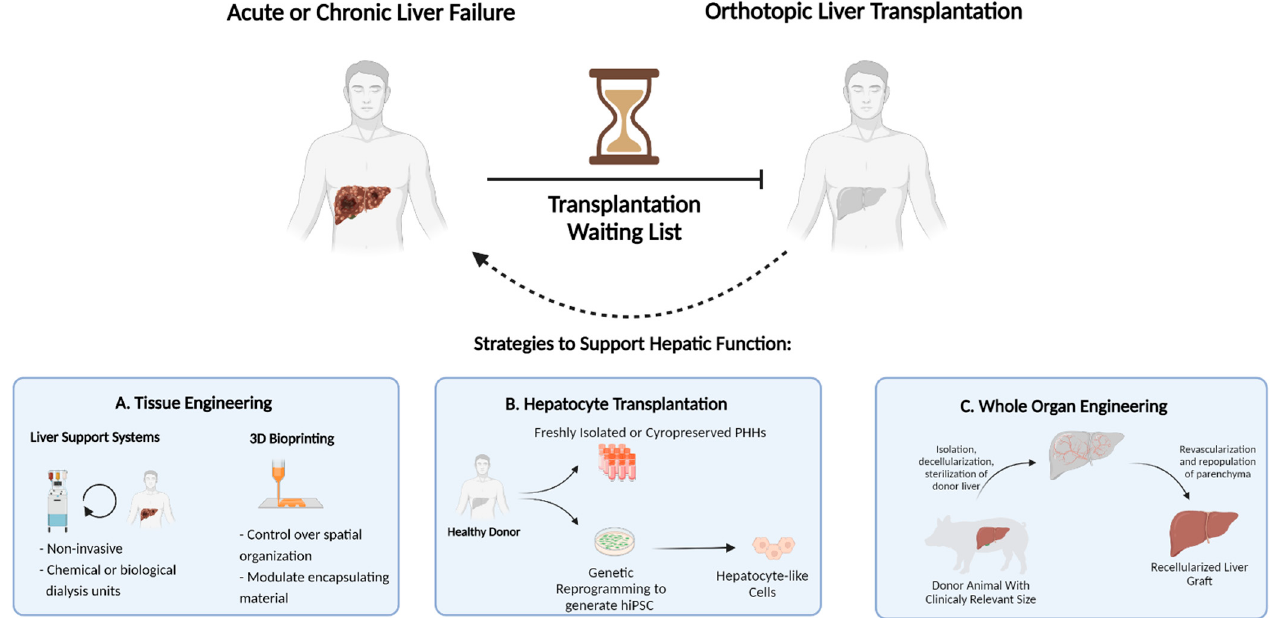
Figure 2. Solutions to expand the lifetime of patients on transplantation waiting list. Hepatocyte transplantation, liver support systems and liver-mimicking artificial constructs, as well as whole- organ engineering, have been proposed to expand the lifetime of the patients with acute or chronic liver failure until suitable graft becomes available.